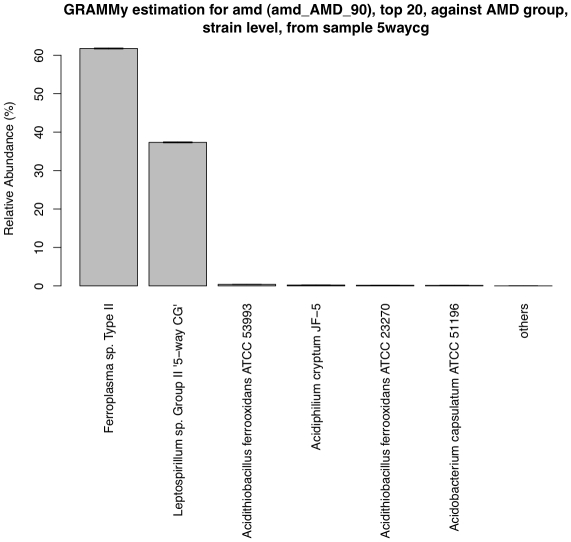
GRAMMy estimates of GRAs for the acid mine drainage data.Estimated relative abundance for each strain is shown as a percentage. The first two strains dominate the sample.